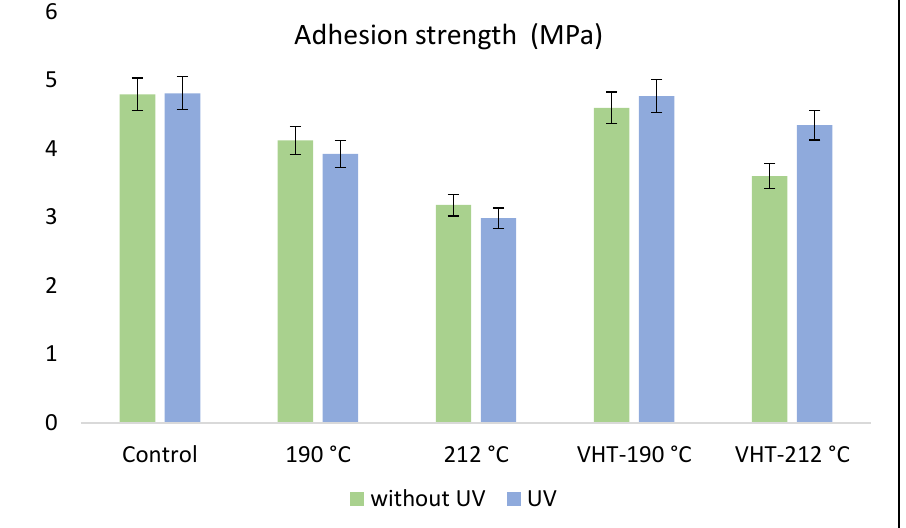
Figure 3. Average adhesion strength values of modified Scots pine wood samples.